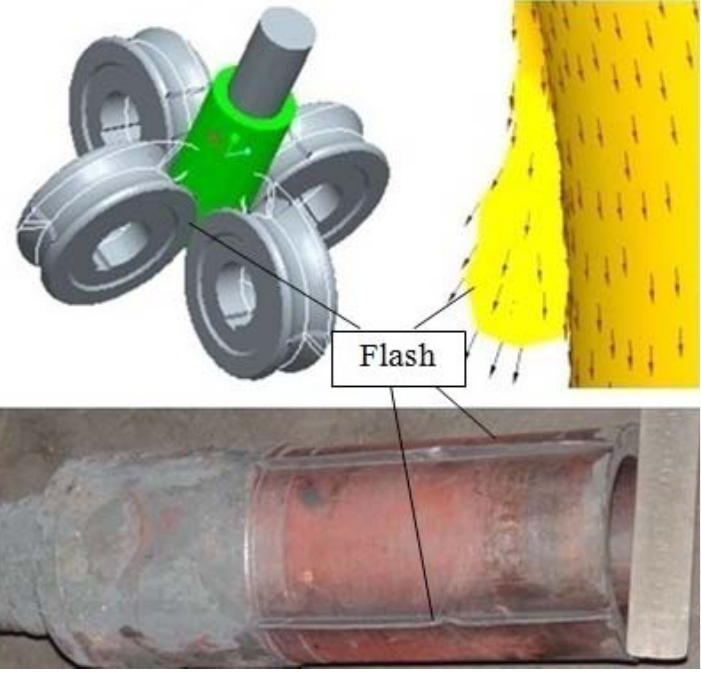
Figure 3. Flash between rollers.